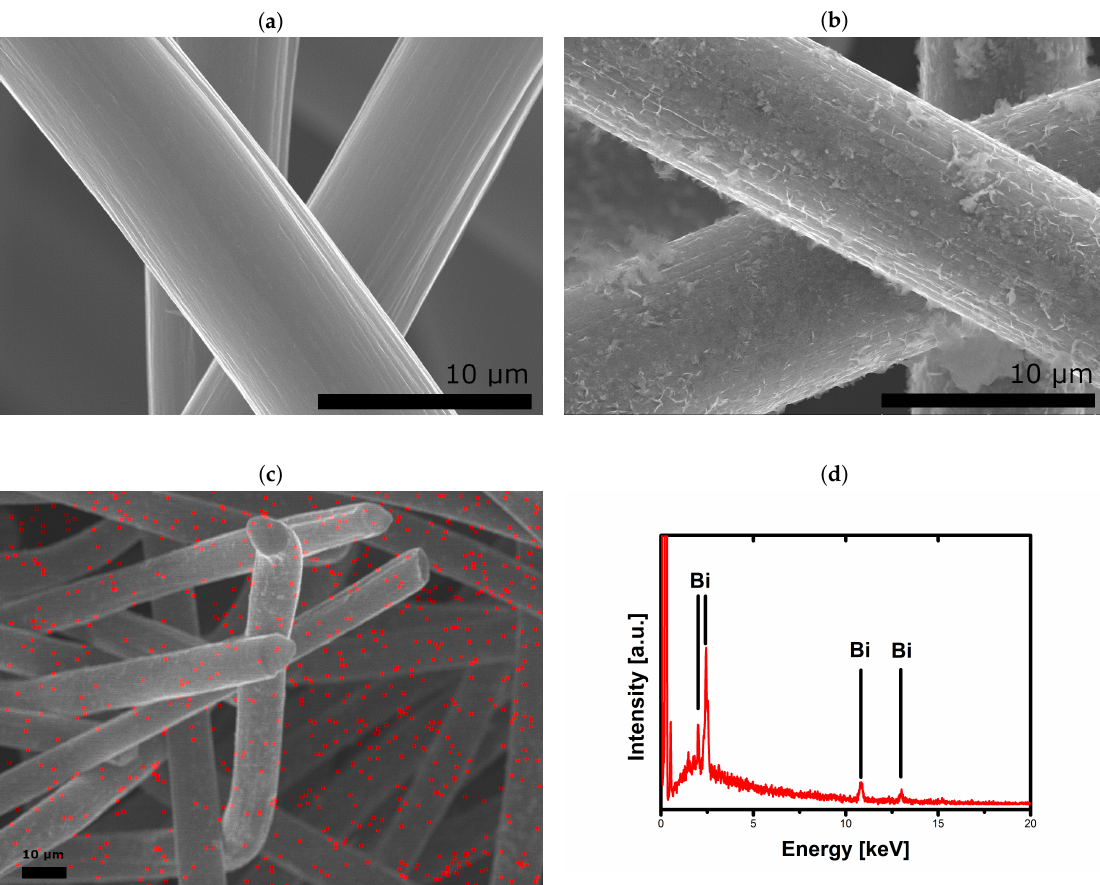
Figure 1. SEM images of fresh carbon felts: ( a ) untreated GFD-U, ( b ) bismuth-modified Bi-GFD and ( c ) elemental mapping for bismuth on Bi-GFD with ( d ) respective EDX spectrum. Electrochemical activity of modified felt electrodes for the V(II)/V(III) redox reaction was evaluated by CV and EIS. Prior to each measurement, electrode samples have been wetted